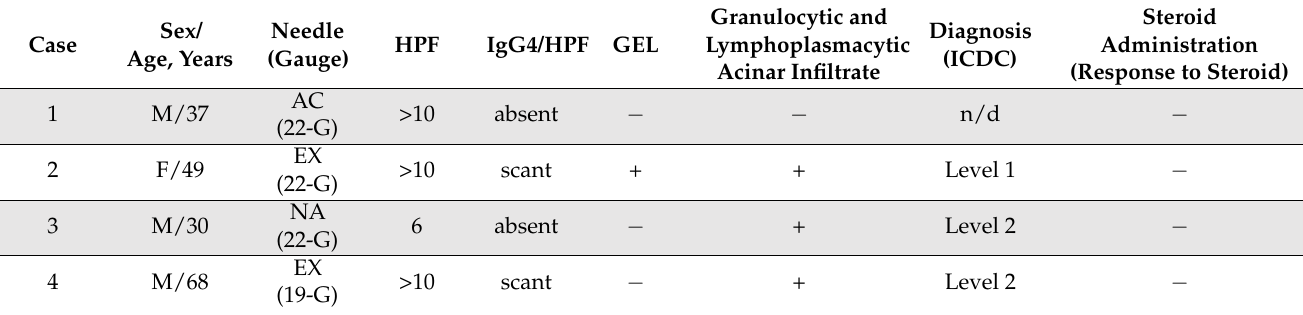
Table 2. Histopathological